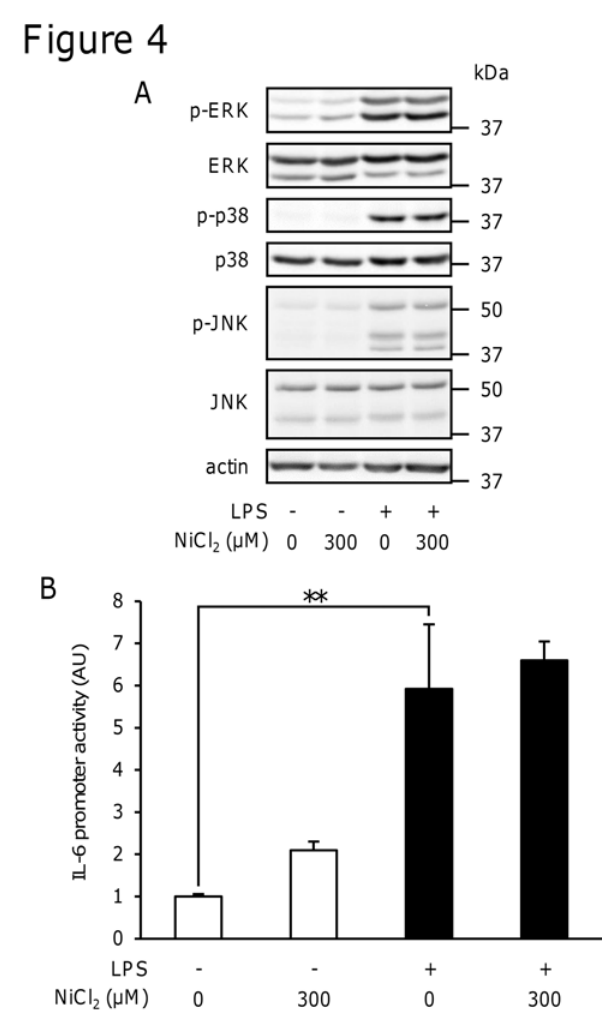
Fig 4. Effects of NiCl2 on the LPS-induced phosphorylation of ERK1/2, p38 MAPK, and JNK as well as IL-6 promoter activity. (A) RAW264 cells were incubated in medium containing LPS (1 μ g/ml) in the presence or absence of NiCl 2 (300 μ M) for 15 min. The protein levels of p-ERK, ERK, p-p38, p38, p-JNK, JNK, and actin were determined in cell lysates by immunoblotting. Data are representative of three independent experiments. (B) RAW264 cells were transiently transfected with a luciferase gene construct with the IL-6 promoter and, 24 h later, were then stimulated for 8 h with LPS (1 μ g/ml) in the presence or absence of NiCl 2 (300 μ M). Luciferase activity was determined in these cells. Values are normalized to those of Renilla luciferase activity and the mean value of the control was set to 1.0. Data represent the mean ± S.E. M. ( n = 3). ** p < 0.01 between the indicated groups. Data are representative of two independent experiments.